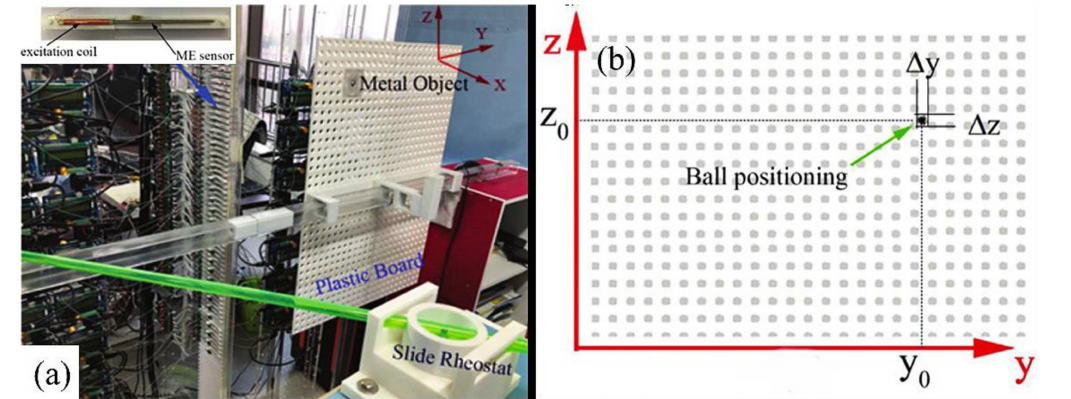
Figure 9. ( a ) Prototype of the measurement setup using 1-D ME sensor array and imaging system. ( b ) the positioning result of an Fe-ball